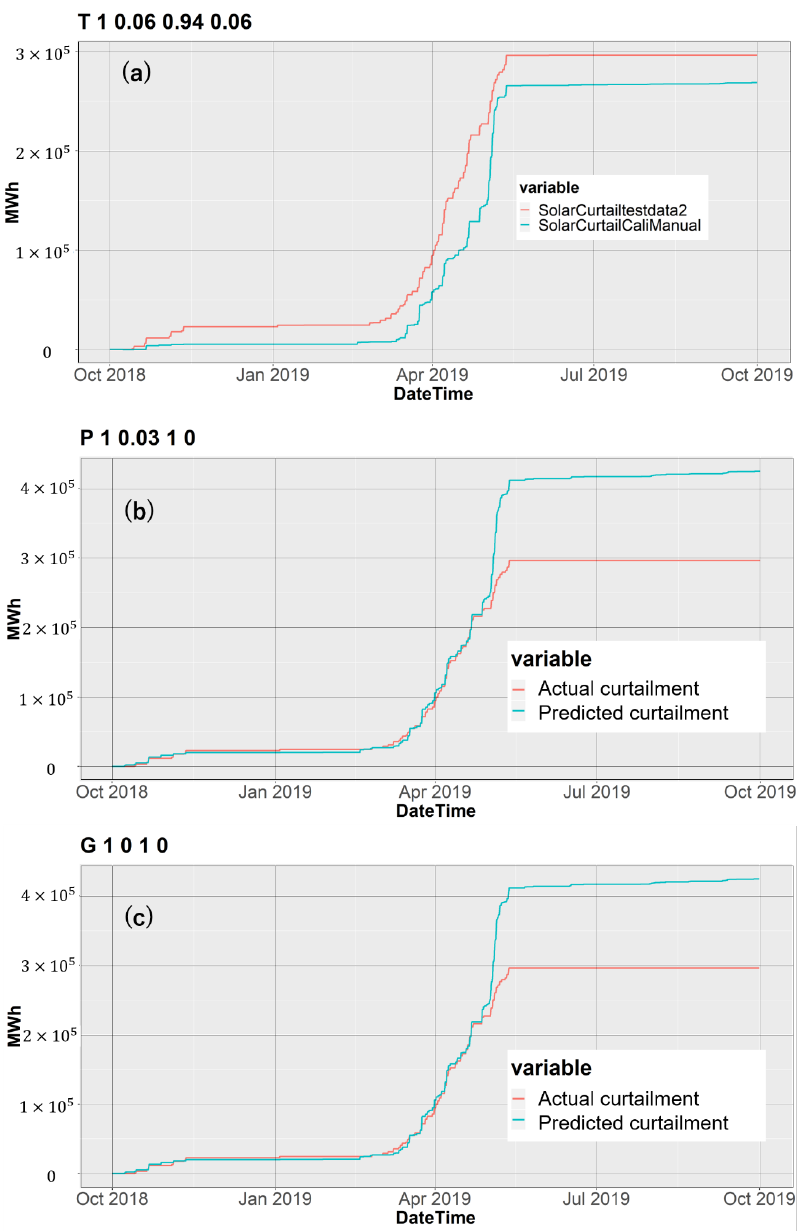
Figure A3. ( a ) Calibration result—T1,0.06,0.94,0.06; ( b ) calibration result—P1,0.03,1,0; and ( c ) calibration result—G1,0,1,0. The red lines indicate the actual cumulative curtailments and the blue lines represent the predicted curtailments.